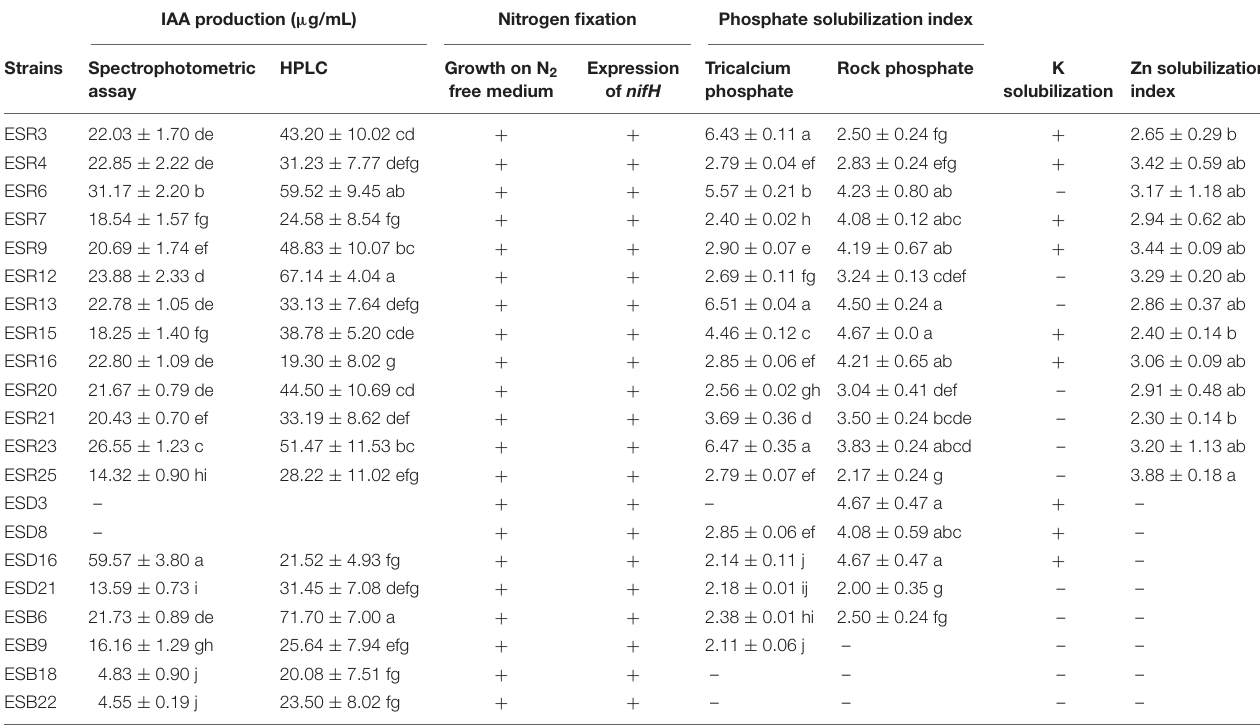
FIGURE 5 | SEM images of biofilm matrices generated by P. chlororaphis ESR3 (A) , P. azotoformans ESR4 (B) , P. poae ESR6 (C) , P. gessardii ESR9 (D) , P. cedrina ESR12 (E) , P. veronii ESR13 (F) , S. maltophilia ESR20 (G) , and B. megaterium ESB9 (H) . TABLE 2 | IAA production and nutrient acquisition by different biofilm-producing